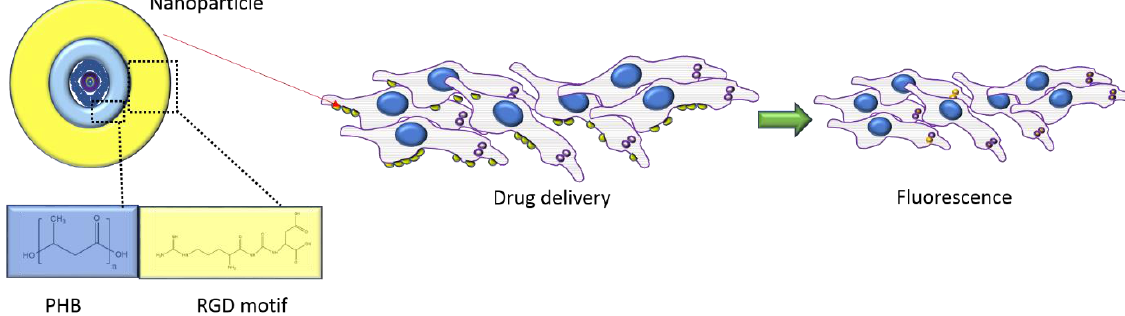
Figure 2. Polyhydroxybutyrate-Arg-Gly-Asp-oligopeptide (PHB-RGD)-based nanoparticles as a drug delivery system to deliver a fluorescent drug to cancer cells in vitro. Freely adapted from Kim et al. 2009 [89] .